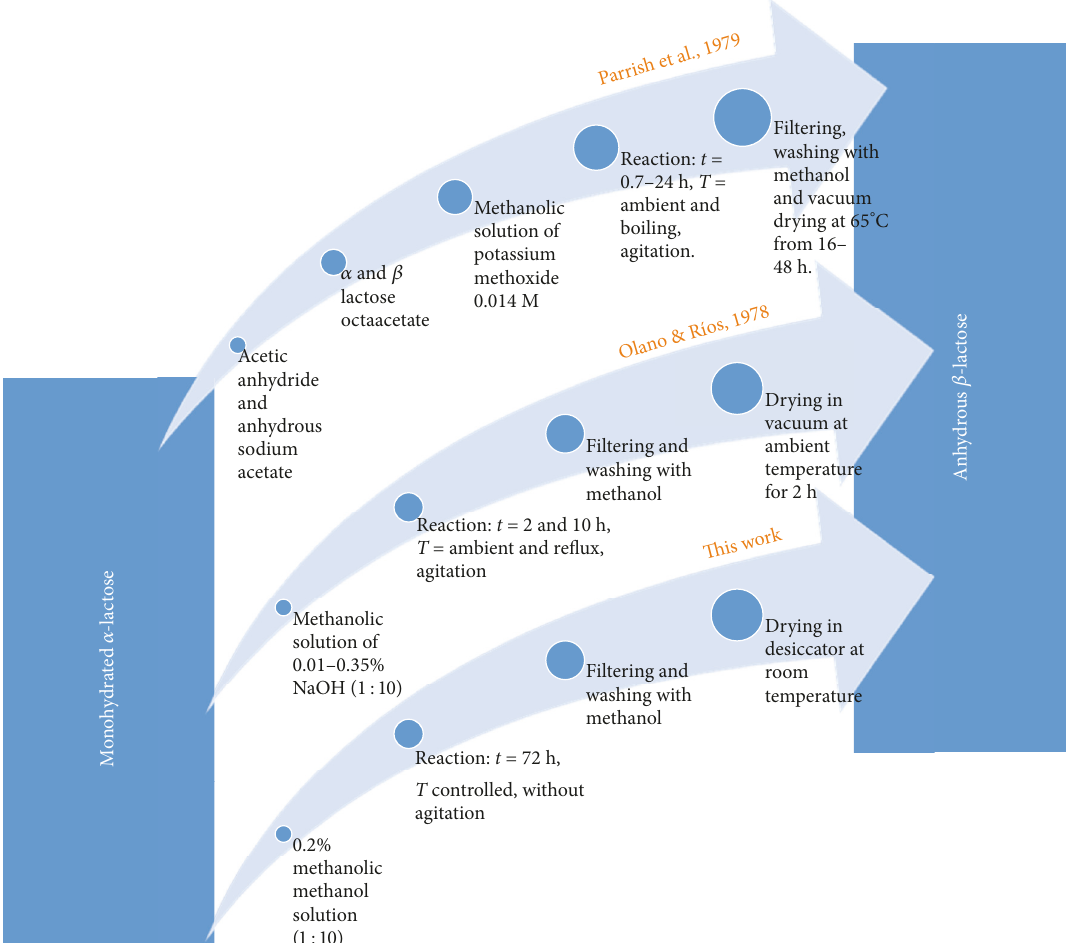
Figure 1: Schematic representation of the methodologies reported by Parrish et al. (1979), Olano & R´ıos (1978), and this